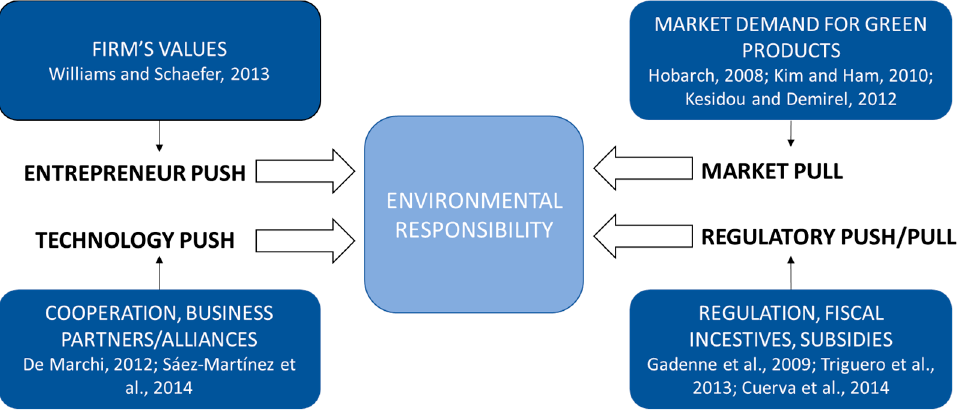
Figure 1. Drivers of environmental responsibility behavior. Adapted from Sáez-Martínez et al. [58].